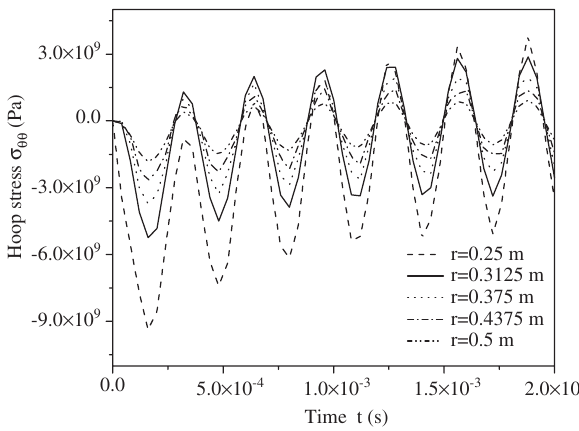
Figure 10 Distributions of hoop stress in the FGM hollow cylinder at different times, where n = 1.